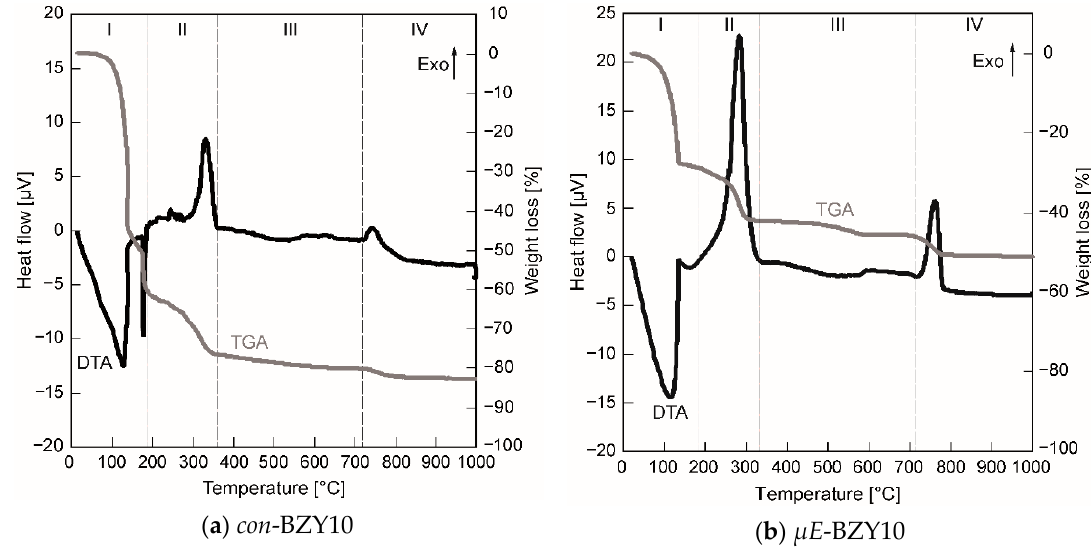
Figure 4. Differential thermo analysis coupled with thermo gravimetry (DTA/TG) analysis of the molecular ( a ) and the BZY10 nanoparticle ( b ) based precursor systems. The four different indicated regions (I–IV), corresponding to evaporation (I), exothermic decomposition (II), no pronounced reaction (III), and crystallization (IV) are discussed in detail in the text.